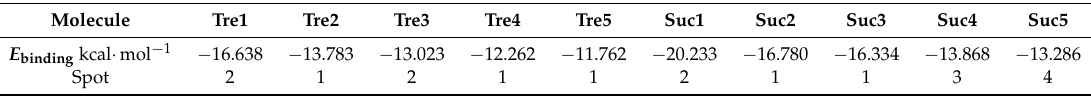
Figure 6. Molecular docking results for trehalose and sucrose obtained with GLUE software. A33 is displayed in blue ribbons, trehalose in black, and sucrose in pink ( left ); The higher affinity molecules are displayed as larger CPK. A33 residues involved in each identified spot ( right ). Table 2. Binding affinity and hotspots for the five lowest energy solutions found for the trehalose and sucrose solutions.